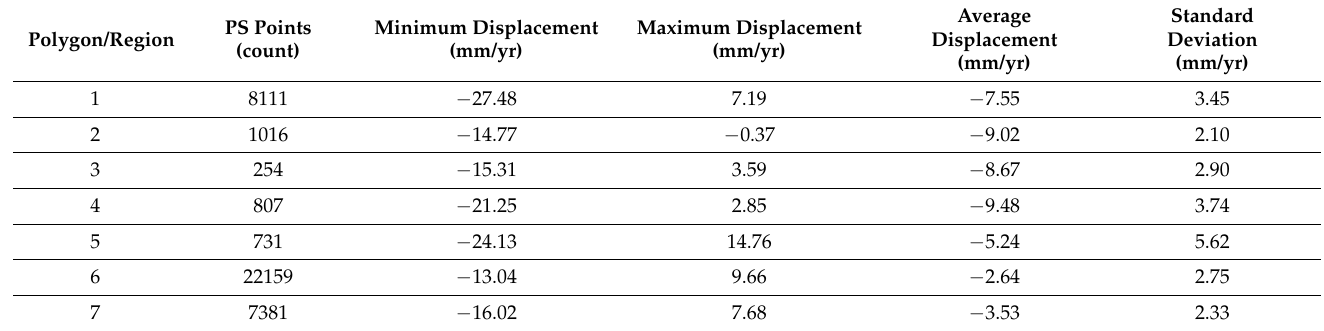
Table 3. Statistics of InSAR-derived land subsidence rates over regions 1–7 shown in Figure 6a.